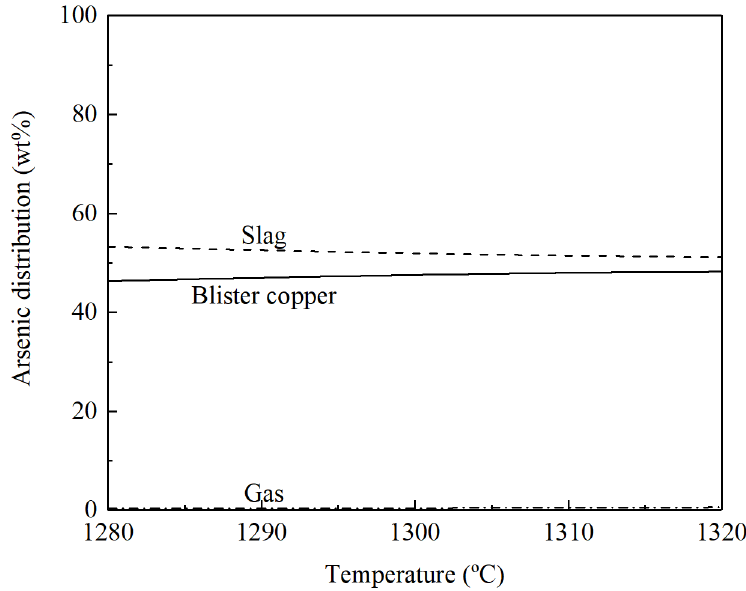
Figure 3. Effect of temperature on arsenic distribution at slag Fe/SiO 2 1.7 and 98.5% Cu in blister